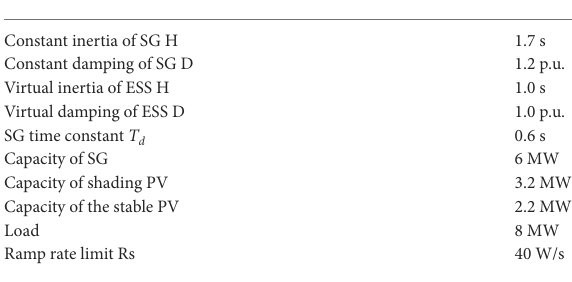
FIGURE 15 Micro-grid frequency response with different control strategies.